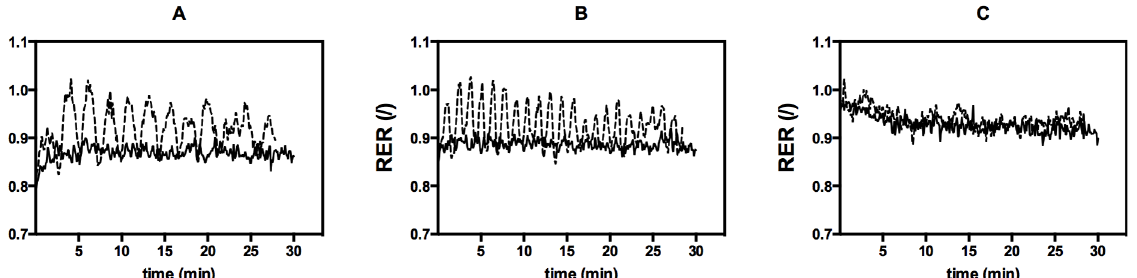
Fig 8. Comparison of the respiratory exchange ratio (RER) response during high-intensity interval exercise (dotted line) vs. continuous exercise (full line) for mean exercise intensities A, B, and C. Values are given as mean.